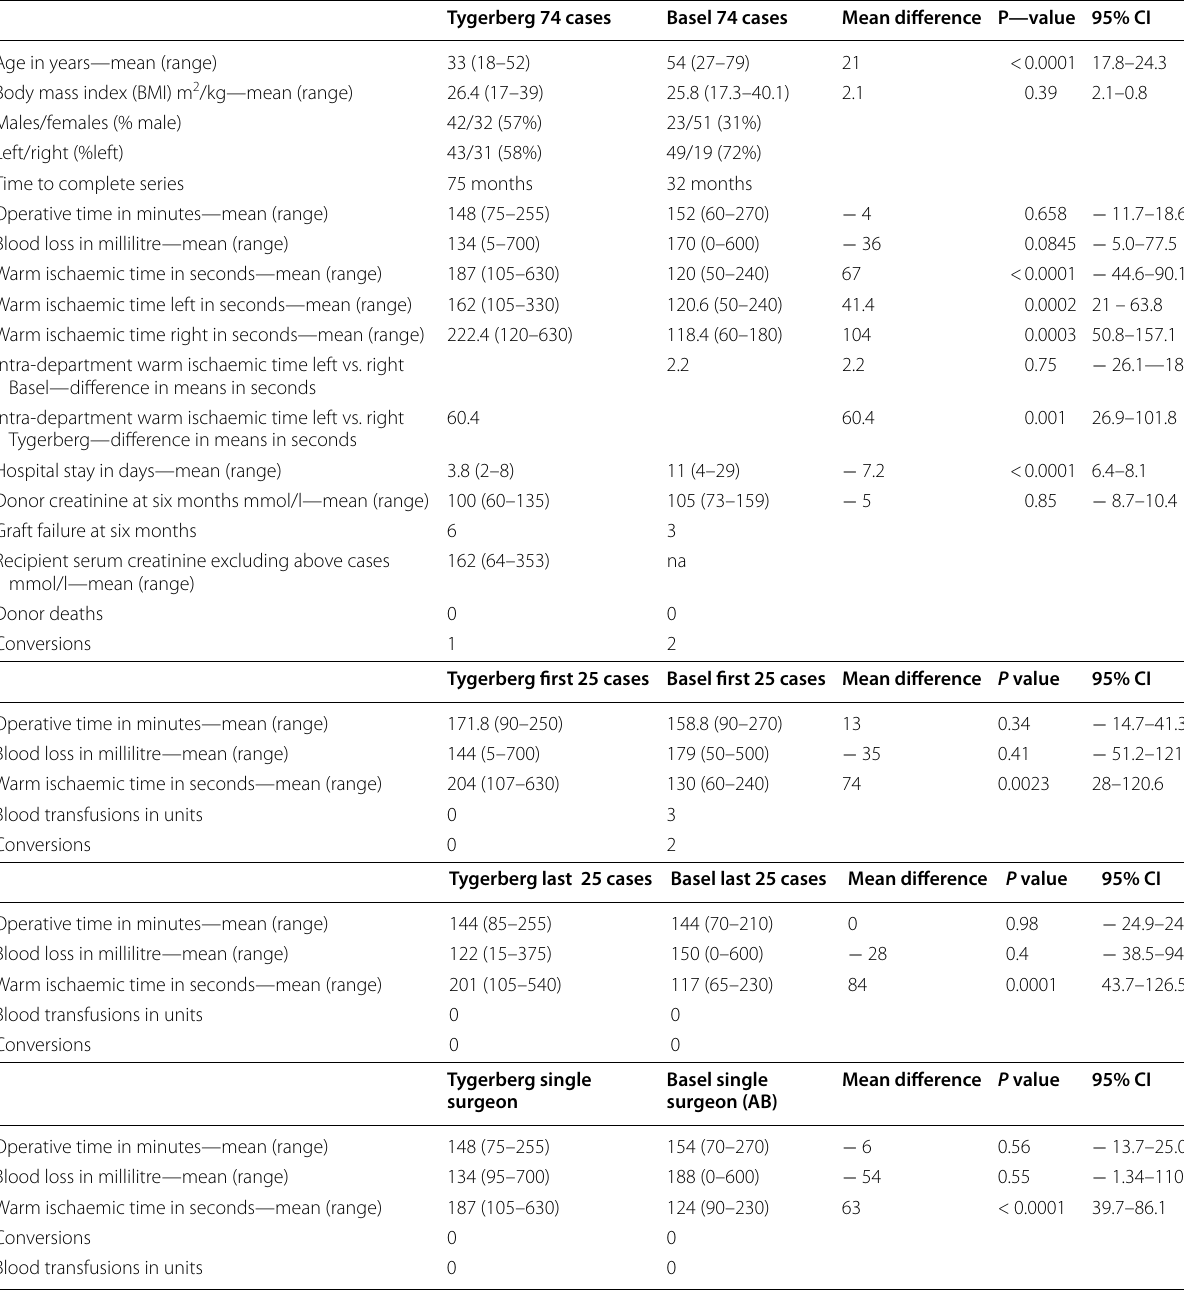
Table 1 Comparative results of renal donor operations at Basel University Hospital Switzerland and Tygerberg Academic Hospital South